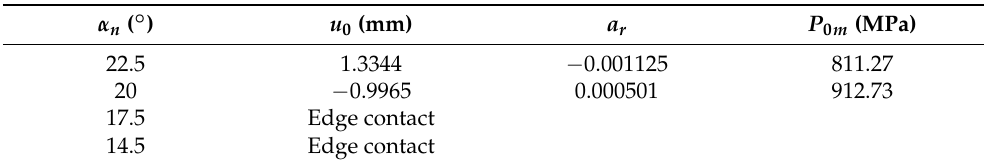
Table 9. Optimization results for different pressure angles α n